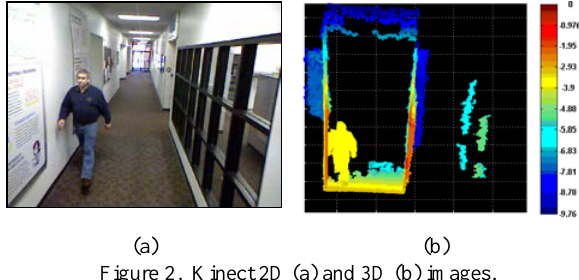
Figure 2. Kinect 2D (a) and 3D (b) images.